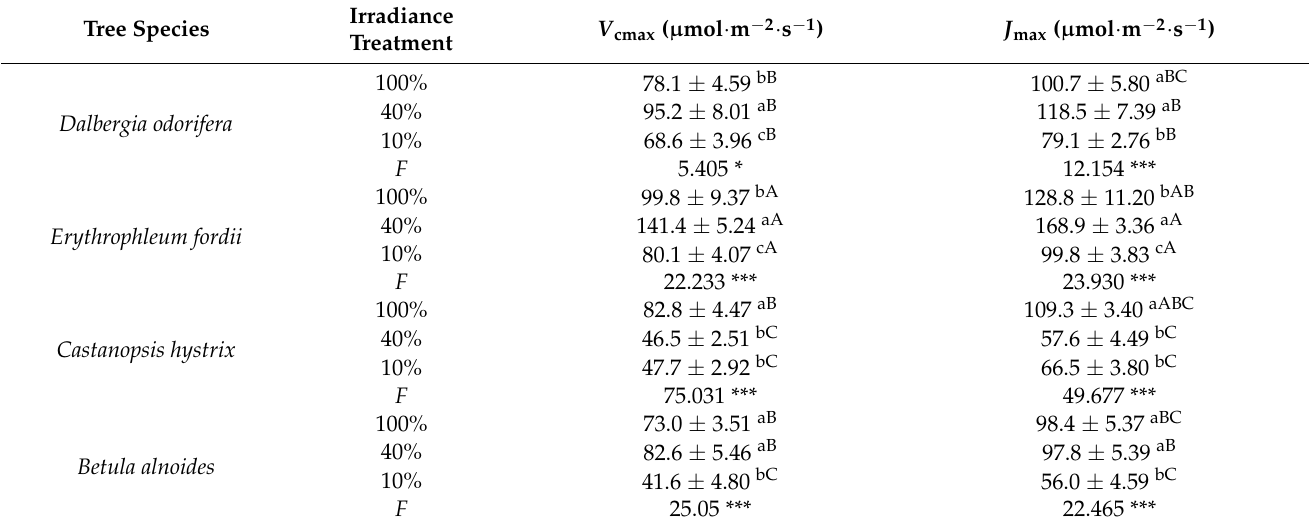
Table 3. Maximum carboxylation rate ( V cmax ) and maximum electron transport rate ( J max ) measured in PPFD-saturated conditions in Dalbergia odorifera , Erythrophleum fordii, Betula alnoides , and Castanopsis hystrix grown under three different irradiance treatments obtained by fitting the Farquhar et al. (1980) model of leaf photosynthesis to the individual A n - C c response curves. Data are means of seven plants per treatment ± SE. Lower case letters indicate significant difference at 0.05 levels among the irradiance treatments, whereas capital letters indicate significant difference at 0.05 levels among species under same irradiance treatment. F -ratios with statistically significant values denoted by * p < 0.05, *** p < 0.001 among irradiance